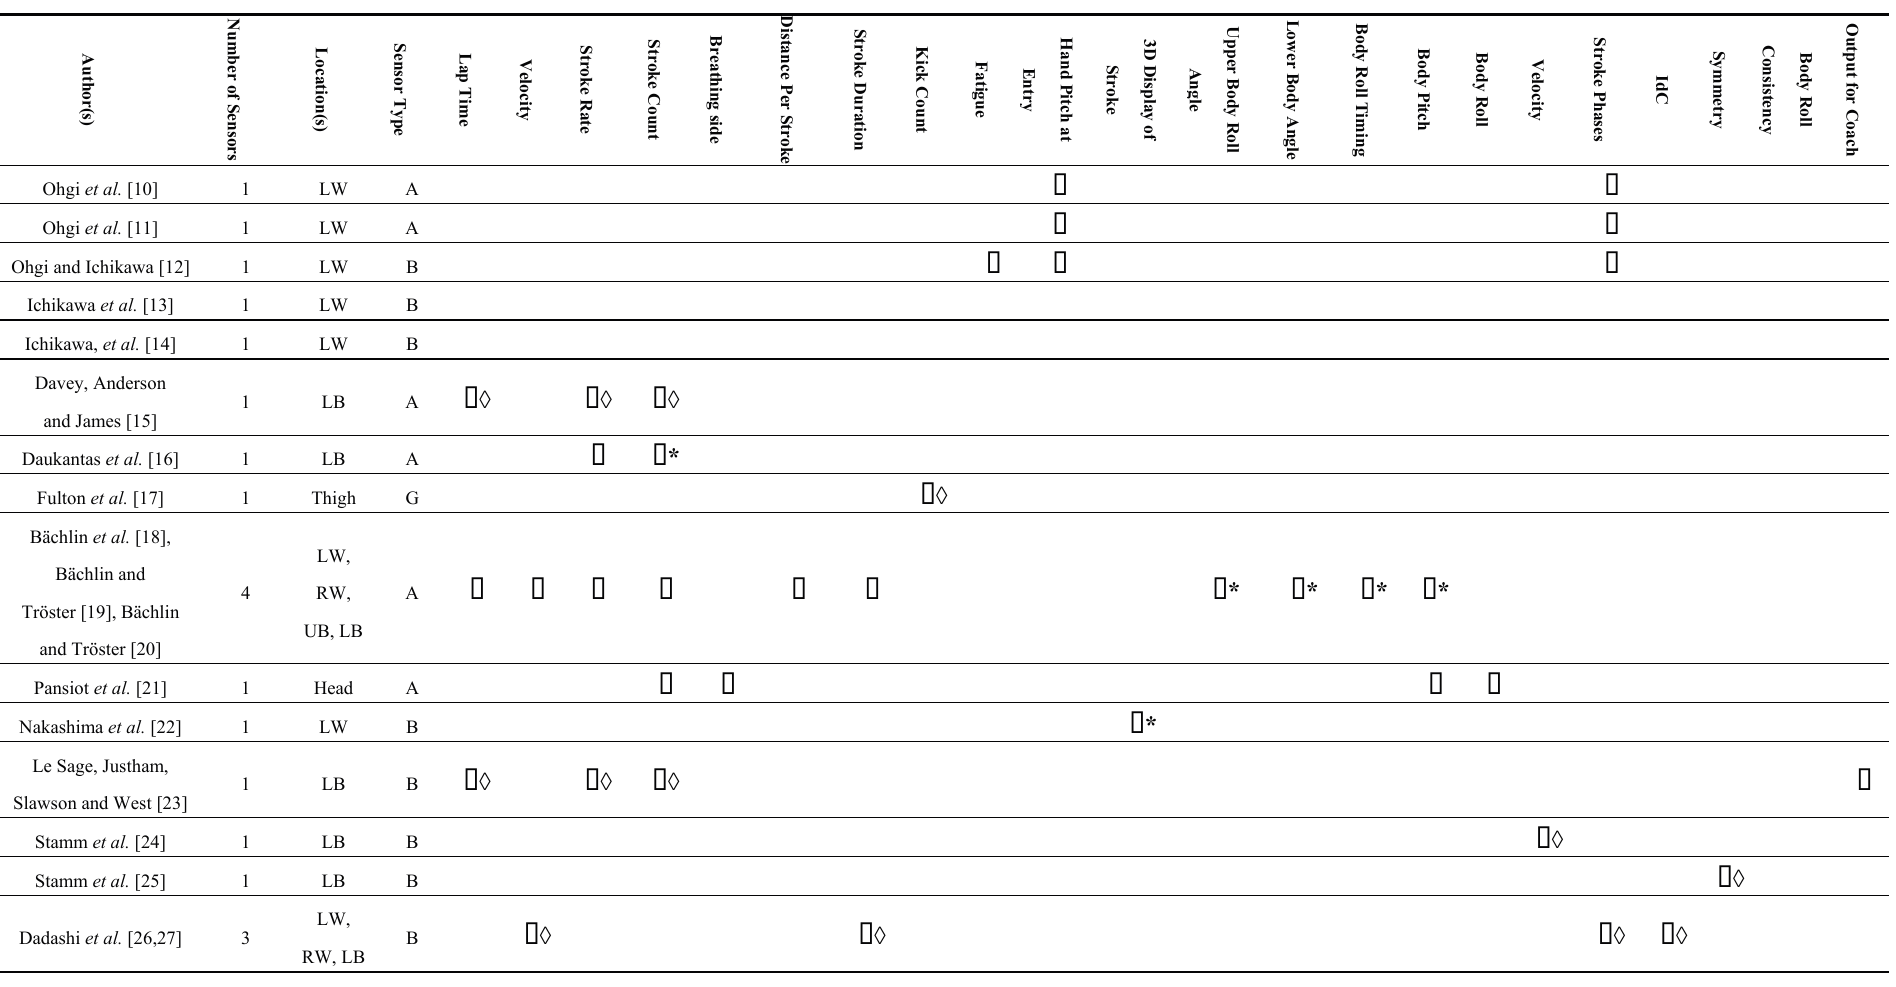
Table 1. Summary of previous works, with the addition of the contribution from this work. A = Accelerometer, G = Gyroscope, B = Both. ◊ = validity and reliability conducted; * = visually compared to video